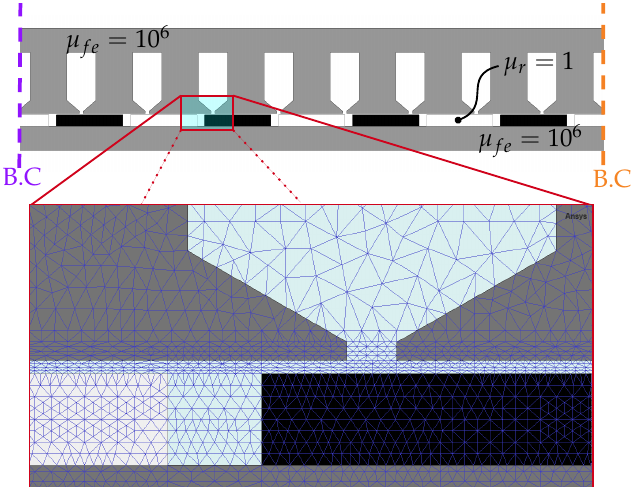
Figure 17. FEM model of the machine case of study and selective zoom of the mesh inside the equivalent air-gap